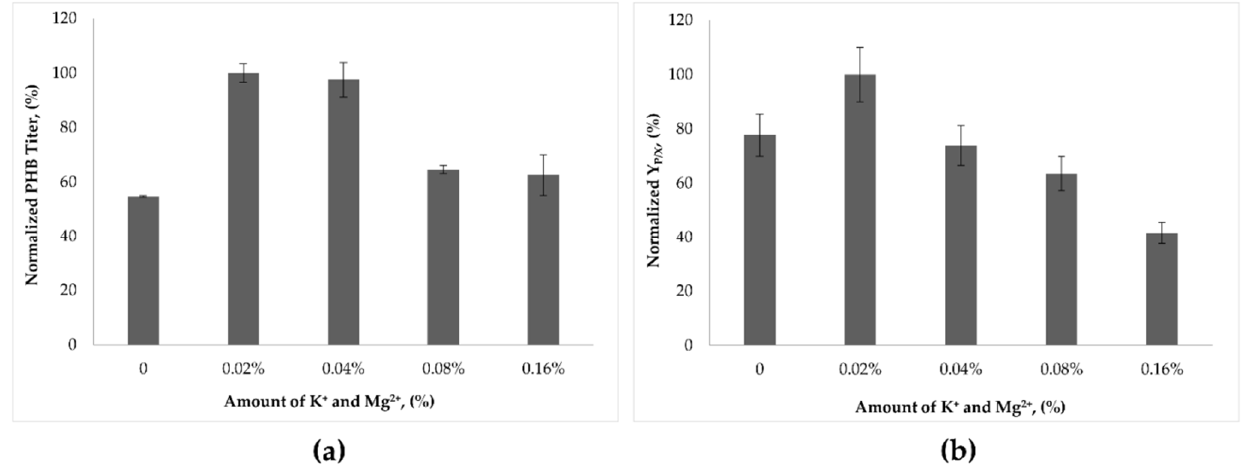
Figure 1. Effect of K + and Mg 2+ ions on PHB synthesis. ( a ) Normalized amount of PHB titer (%). ( b ) Normalized Y P/X (%).